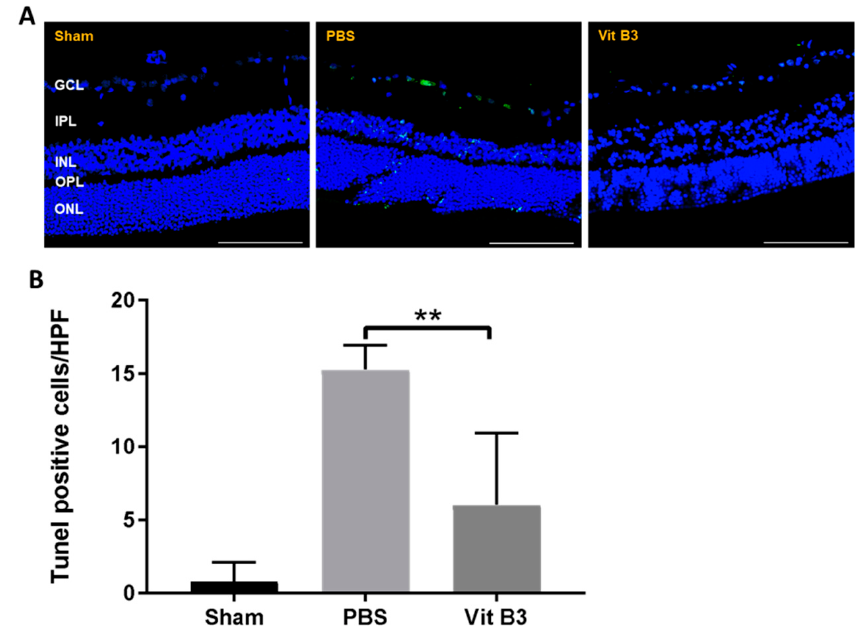
Figure 3. TUNEL assay analysis of RGC apoptosis in the RGC layer on day 28 following rAION induction. ( A ) Images of each group of retinal apoptotic cells after double staining. Blue staining was used to identify nuclei, whereas green staining was employed to identify apoptotic cells. ( B ) Calculation of the number of TUNEL-positive cells per HPF. The amount of TUNEL-positive cells was much less in the vitamin B3-treated group than it was in the PBS-treated group (** p < 0.01; n = 6 per group; scale bar: 100 μ m). Data were presented as mean ± SD. GCL, ganglion cell layer; IPL, inner plexiform layer; INL, inner nuclear layer; OPL, outer plexiform layer; ONL, outer nuclear layer.